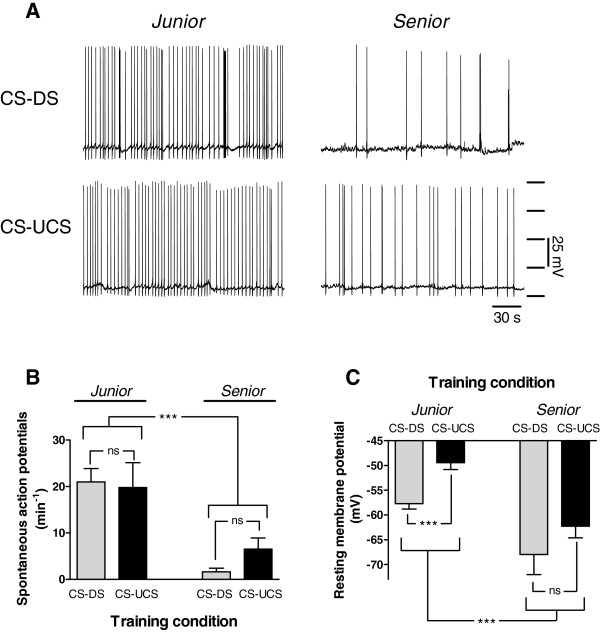
Electrophysiological assessment of CGCs in Junior and Senior animals. A.  Examples of intracellular recording of spontaneous electrical activity in CGCs of junior and senior conditioned (CS-UCS) and unconditioned control (CS-DS) animals. B. Average number of spontaneous action potentials of CGCs in both junior and senior conditioned and control animals. Aged CGCs showed a significantly lower spontaneous action potential firing rate than junior CGCs No significant difference was observed between the control and conditioned groups within each age category. C. Resting membrane potential of junior CGCs was more depolarized compared with senior CGCs. Behavioural conditioning further depolarized resting membrane potential in junior but not in senior animals. * = p < 0.05, *** = p < 0.001, ns = non-significant.